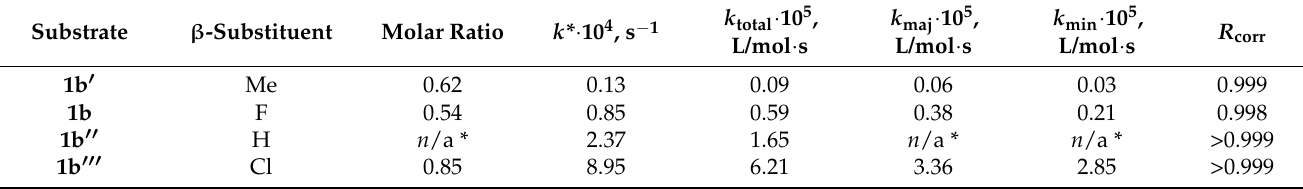
Table 3. Kinetic data of the reactions of β -substituted nitrostyrenes with